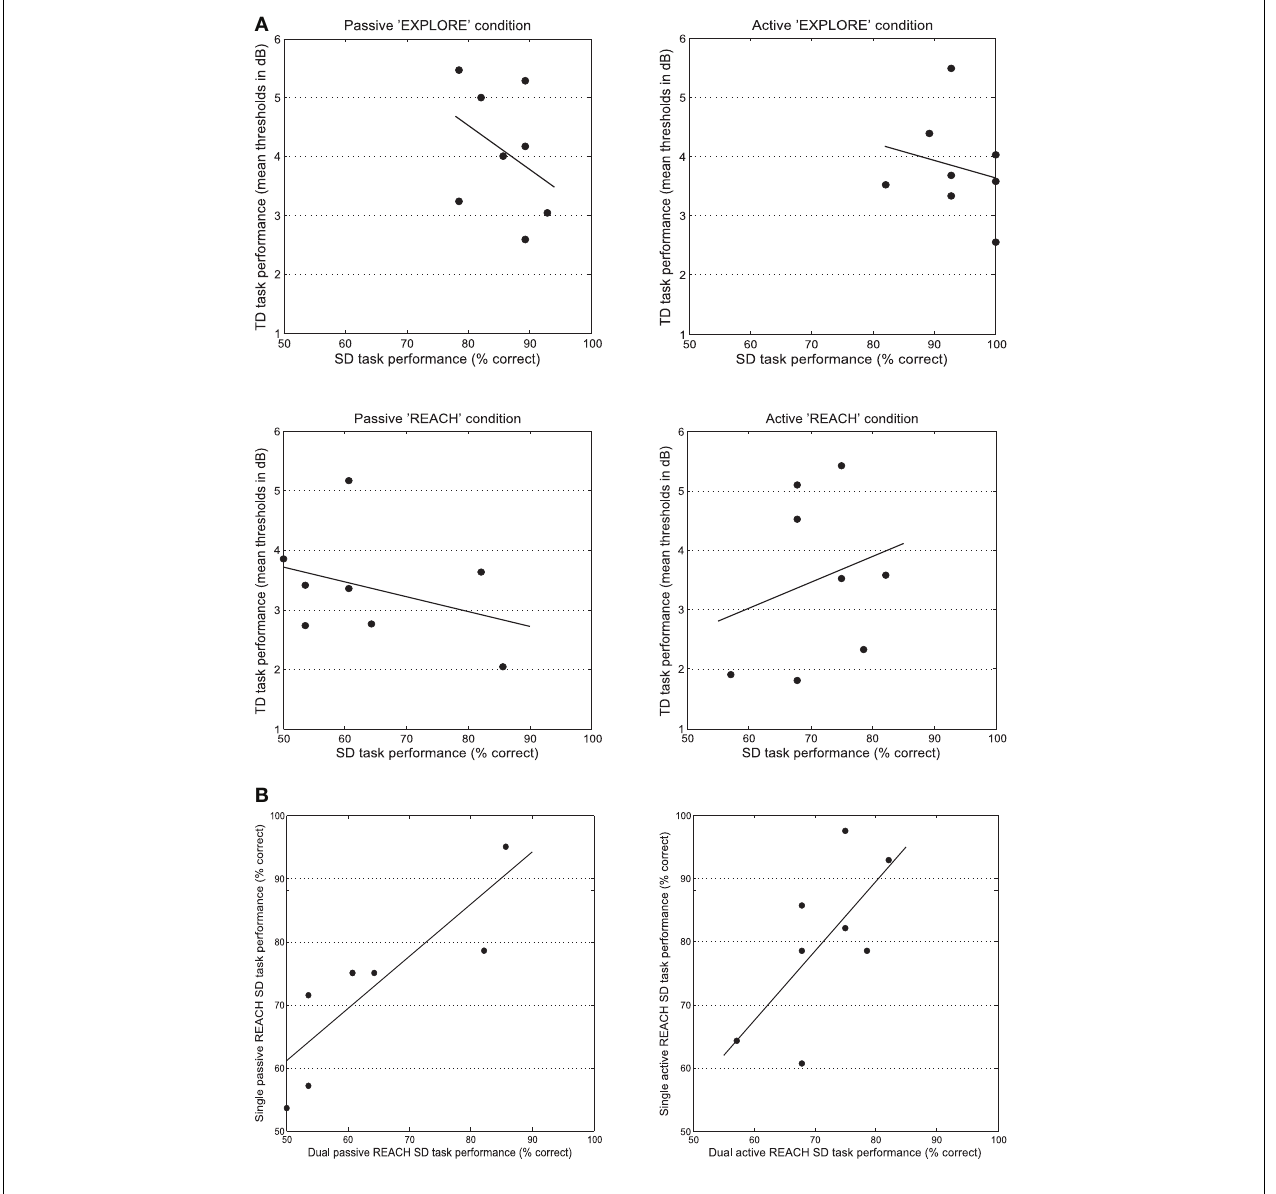
FIGURE 5 | Scatter plots of TD task performance (in dB) plotted against the performance in the SD task (% correct) for all of the dual task conditions. The dots represent the mean threshold data from individual